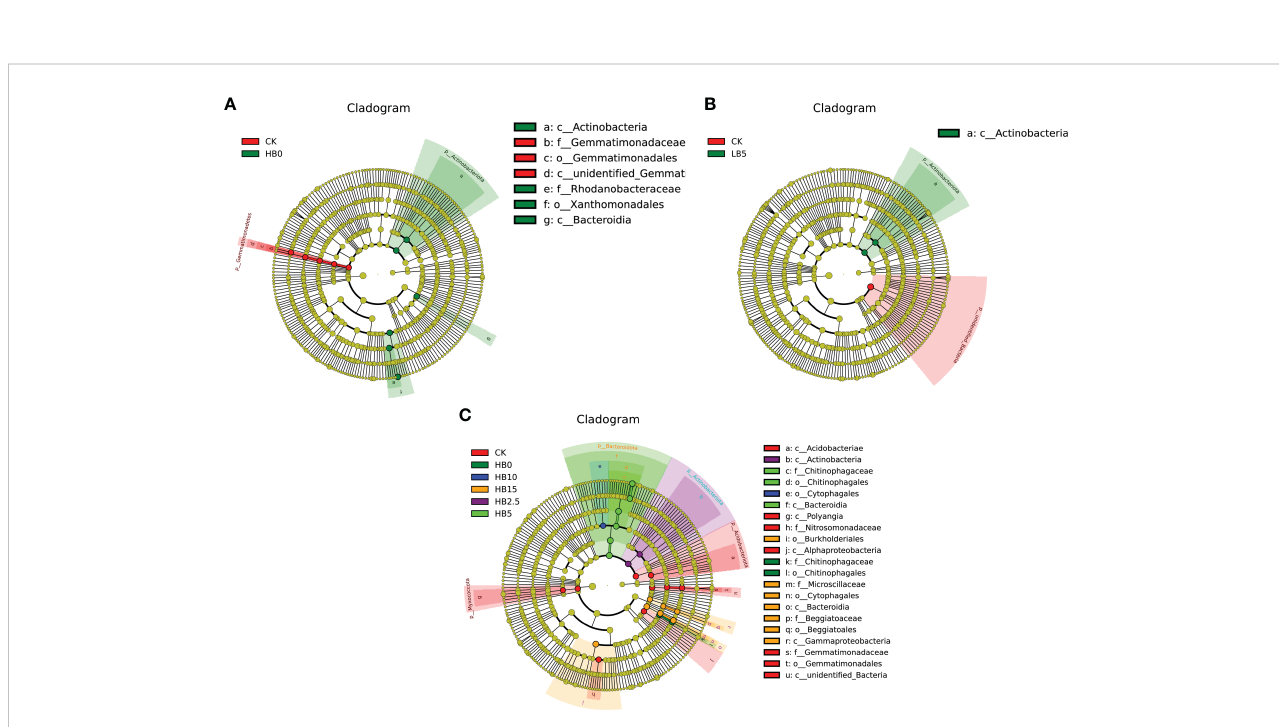
FIGURE 6 LefSE analysis results of bacterial community members. (A) Pb application alone, (B) CSB effect under low Pb toxicity and (C) CSB effect under high Pb